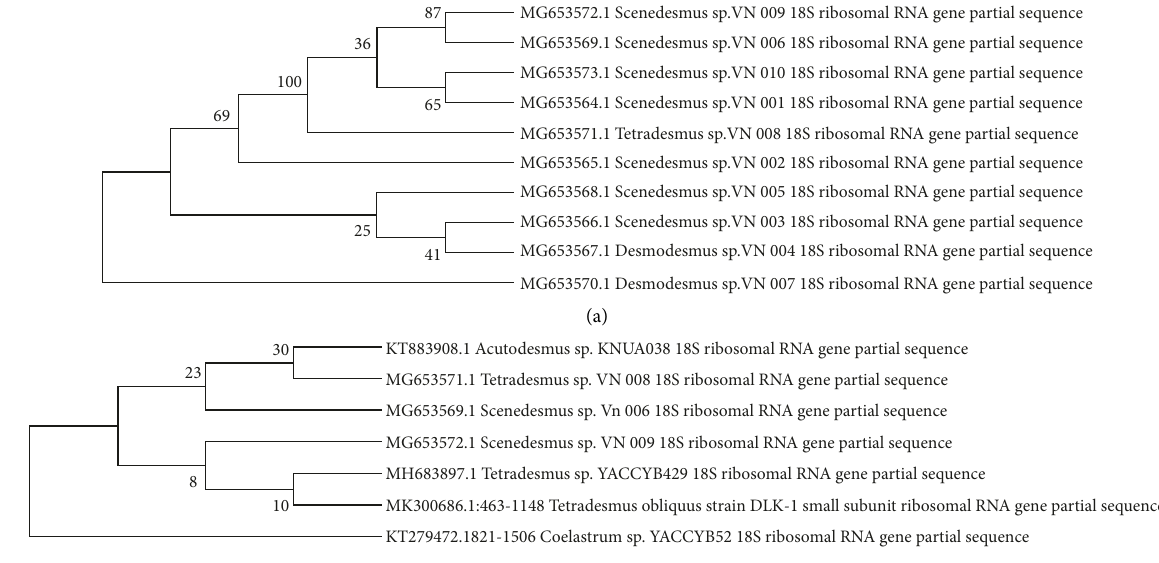
Microalgal culture collection of Shiraz university of medical sciences (MCCS).